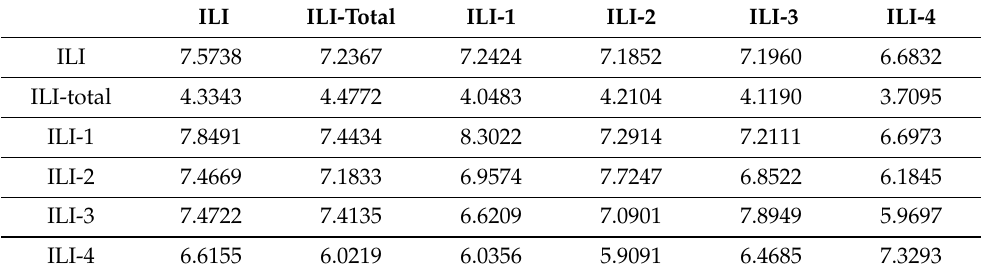
Table 4. Matrix [ AV ] Max ,20,6